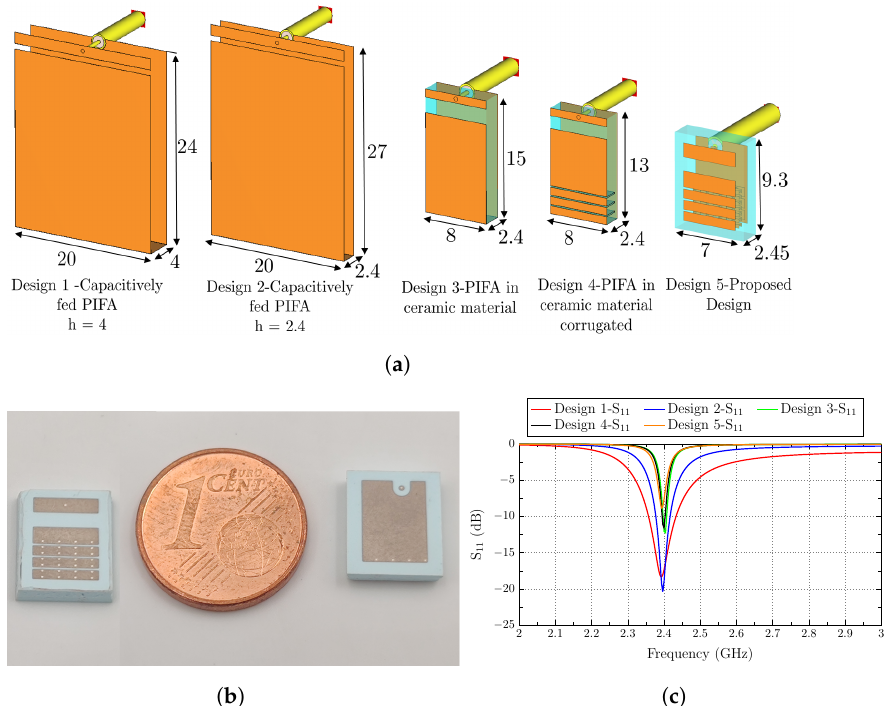
Figure 2. ( a ) Miniaturization process for obtaining the proposed antenna (from Design 1 to the proposed design (Design 5)) with dimensions in mm, ( b ) front and bottom view of the fabricated antenna, and ( c ) reflection coefficients (S 11 ) from Design 1 to Design